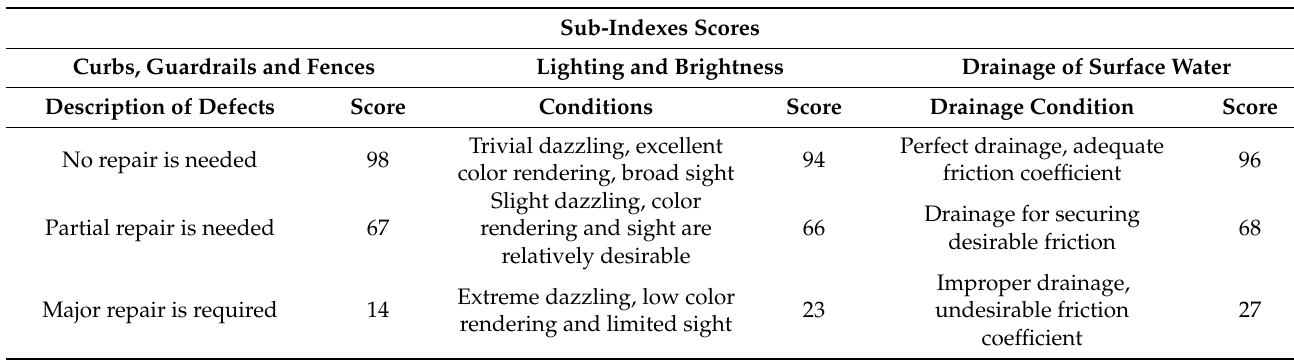
Table 12. Score of sub-indexes in safety